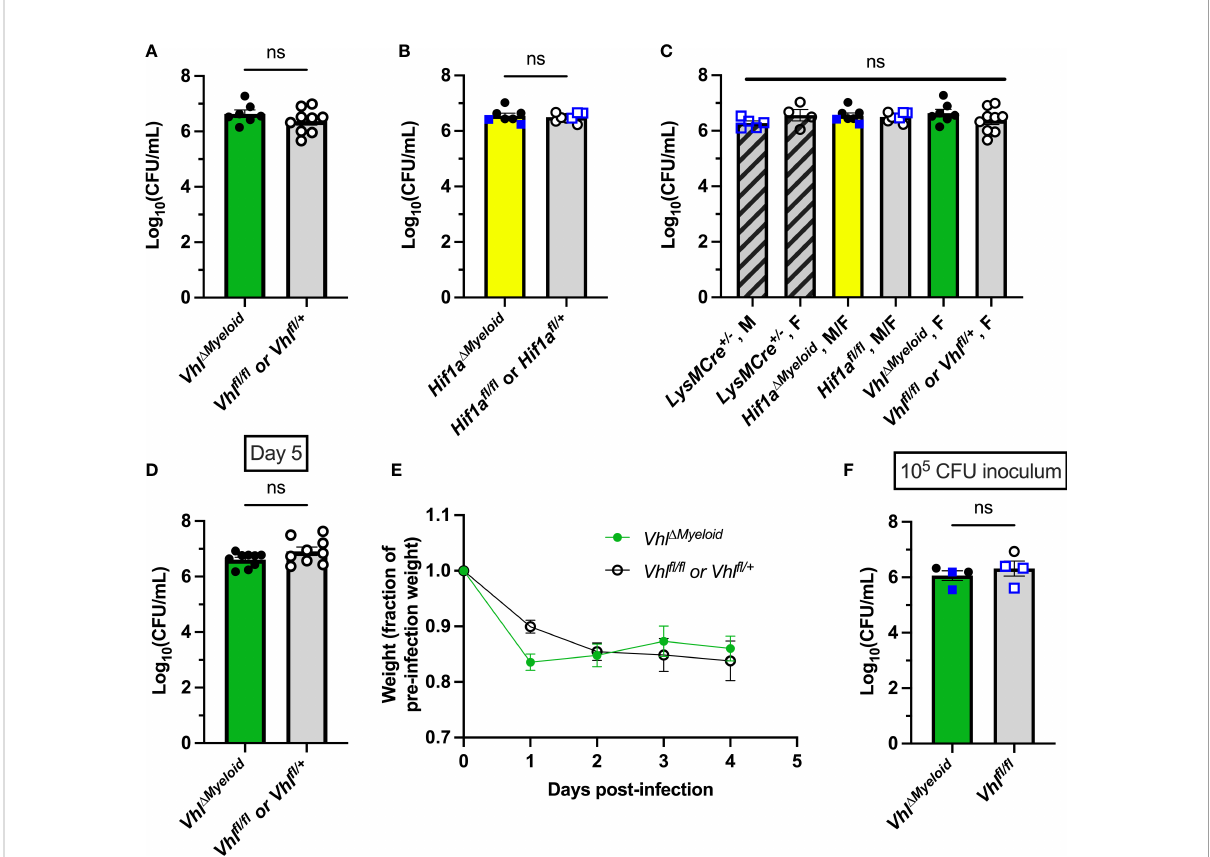
FIGURE 4 Myeloid-lineage conditional knockout of Hif1a or Vhl does not alter bacterial burdens during S. aureus osteomyelitis. (A) Day 14 post-infection bacterial burdens from infected femurs of female Vhl D Myeloid mice or Cre-negative controls composed of both Vhl fl / fl and Vhl fl /+ littermates ( n =7-9). (B) Day 14 post-infection bacterial burdens from infected femurs of Hif1a D Myeloid mice and Cre-negative controls, which are composed of both Hif1a fl / fl and Hif1a fl /+ littermates. Mice ( n =7-8) are female except for those marked with blue squares, which represent data from male mice. (C) Day 14 post-infection bacterial burdens from infected femurs of male and female (as labeled) age-matched LysMCre +/- mice ( n =4) that do not contain fl oxed alleles are shown along with the data displayed in (A, B) for comparison between all groups. (D) Bacterial burdens were determined in the infected femurs of Vhl D Myeloid mice and Cre-negative littermate controls ( Vhl fl / fl or Vhl fl /+ ) at day 5 post-infection ( n =9). (E) The relative post-infection weights corresponding to the experiment shown in (D) are shown relative to the pre-infection starting weight; ( n =4-5 from fi rst half of mice in the experiment — when weights were measured daily). Relative post-infection weights do not differ between genotypes as compared by two-way analysis of variance (ANOVA). (F) Bacterial burdens were determined in the infected femurs of Vhl D Myeloid and Cre-negative littermate controls ( Vhl fl / fl ) at day 14 post-infection following infection with a lower inoculum of 10 5 CFU. Error bars represent mean±SEM, and ns denotes difference did meet the p < 0.05 standard for signi fi cance as determined by unpaired, two-tailed Student ’ s t -tests (A, B, D, F) or one-way ANOVA (C) . CFU=colony forming